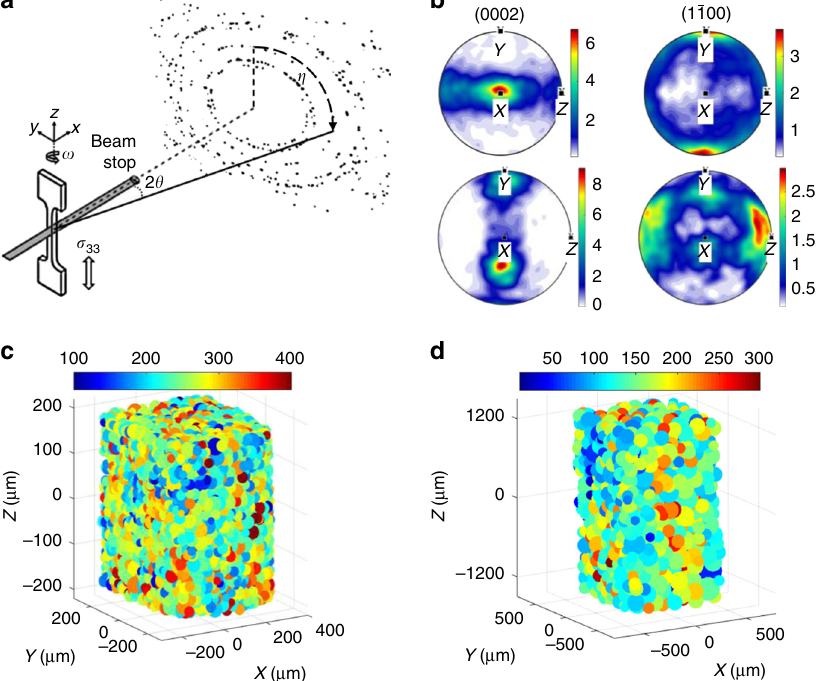
Fig. 1 The setup and the results of the 3D-XRD experiments on CPZr and CPTi. a A schematic of the 3D-XRD experimental setup. Results of 3D-XRD: b measured pole fi gures (in mrd) for CPZr (top) and CPTi samples (bottom). Distribution of σ 33 (in MPa) at the maximum applied strain for ( c ) CPZr and ( d )